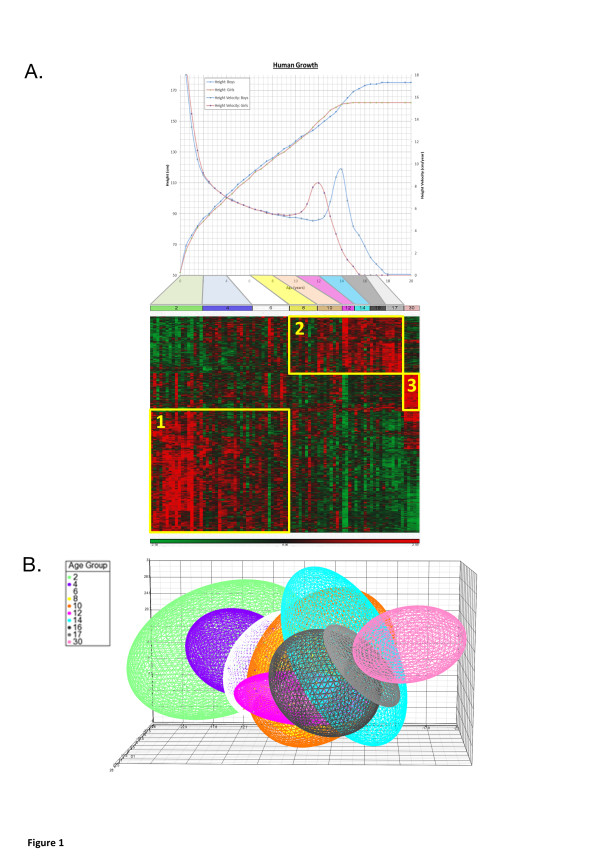
Differential age-associated gene expression. A. Heat map of age-associated changes in gene expression in 87 individuals (0.2 to 29.3 years of age - average 7.7+/−7.0 yrs). 927 gene expression probes were significantly associated with age (ANOVA, false discovery rate (FDR) corrected p-value, q < 0.1, with both gender and study used as co-variates. Supervised hierarchical clustering using Kendell’s dissimilarity and Ward’s method identified three main clusters of gene expression probes: ≤6 years of age [infancy, early childhood group (408 probes)]; >6 to ≤17 years of age [late childhood, puberty group (252 probes)]; and >17 to <30 years of age [adulthood (267 probes)]. Gene expression is shown between +2.5 fold and −2.5 fold, red = increase in gene expression, green = decrease in gene expression. Human growth curve data from normal controls [18,19] shown in relation to the heat map, age groups coloured by upper limit of group bins (years). B. Multi-dimensional scaling (MDS) of the 927 development-related gene expression probes shows distinct development-related clustering; ellipsoids represent 2 standard deviations of normalised gene expression, colour coded by age. Axes represent proportion of variation as defined by MDS (%).